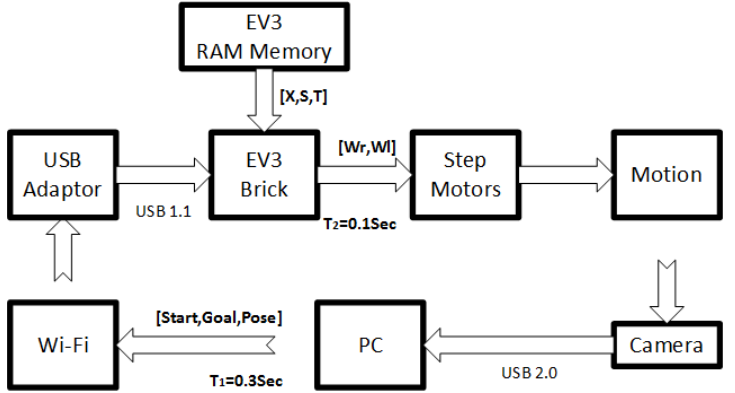
Figure 4. Block diagram of the Lego ® vehicle experimental setup.